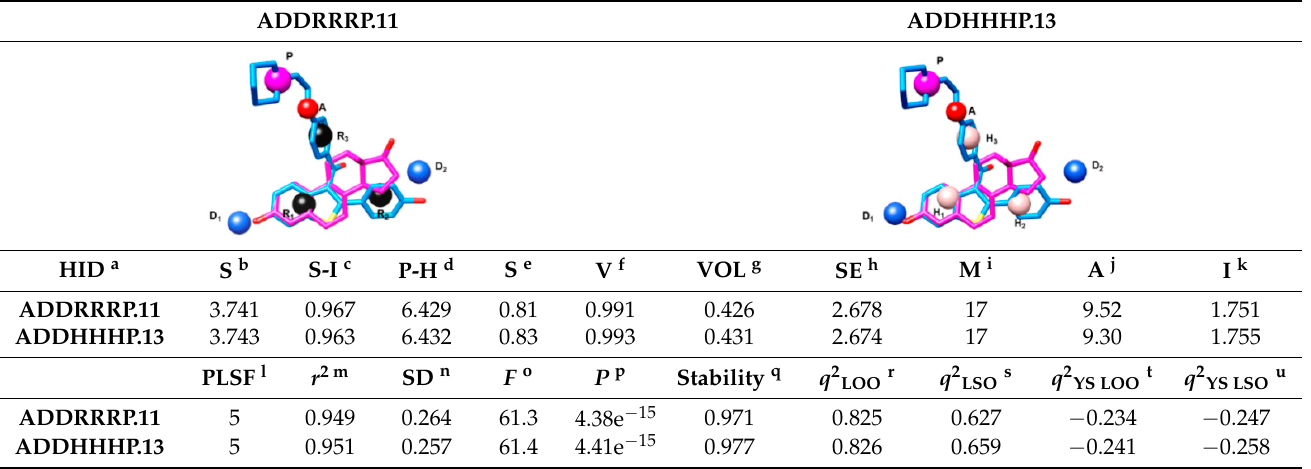
Table 4. The alignment of best hypotheses pharmacophoric features ( A : hydrogen-bond acceptor, D: hydrogen bond donor, R : ring feature, H : hydrophobic feature, P : positive ionizable feature) against 1ERR (blue) and 1ERE (pink). Scores of the different parameters (the upper part) and PLS statistical parameters (the lower part) of the top two hypotheses. ADDHHHP.13